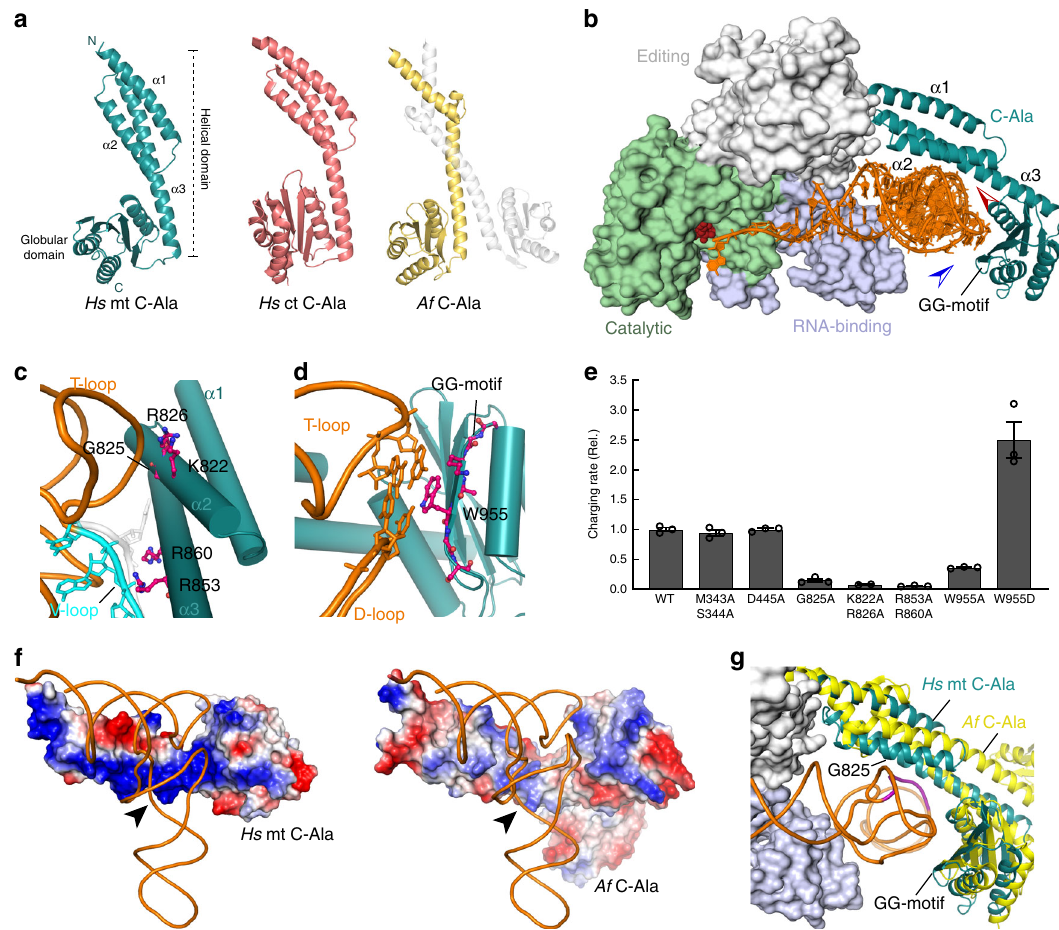
Fig. 4 mt tRNA Ala recognition by mt C-Ala. a Structures of Hs mt C-Ala (left), Hs ct C-Ala (middle), and A. fulgidus C-Ala (right). b Structure model of mt tRNA Ala (orange) bound to Hs mt AlaRS. The crystal structure of mt C-Ala is shown in cyan. Red and blue arrows indicate views in ( c ) and ( d ), respectively. c , d Details of the possible interaction interfaces between mt C-Ala and tRNA as indicated by the model. c Interaction of T-stem-loop (orange) and V-loop (cyan) with the N-terminal subdomain. d Interaction of T-loop and D-loop (orange) with the globular subdomain. In ( c ), the additional V-loop nucleotide that is absent in mt tRNA Ala but present in ct tRNA Ala (as U47), is shown in transparent gray. e Impact of mutations in Hs mt AlaRS on mt tRNA Ala charging. Error bars represent SEM of triplicate experiments. Source data are provided as a Source Data fi le. f Comparison of surface charge distributions in Hs mt C-Ala (left) and Af C-Ala (right). Blue indicates positive, red is negative surface charge. Arrows indicate the position of the V-loop. g Superposition of Hs mt C-Ala (cyan) and Af C-Ala (yellow) based on the C-terminal globular domain (see also Supplementary Figs. 7 and 9; see Supplementary Table 1 for data collection and re fi nement